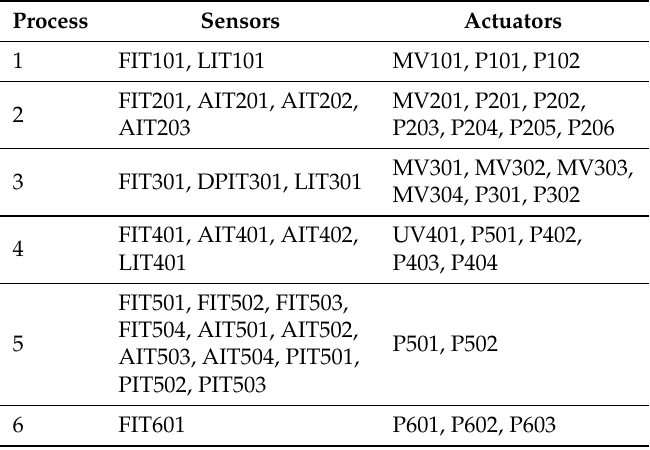
Table 1. Sensors and Actuators in SWaT